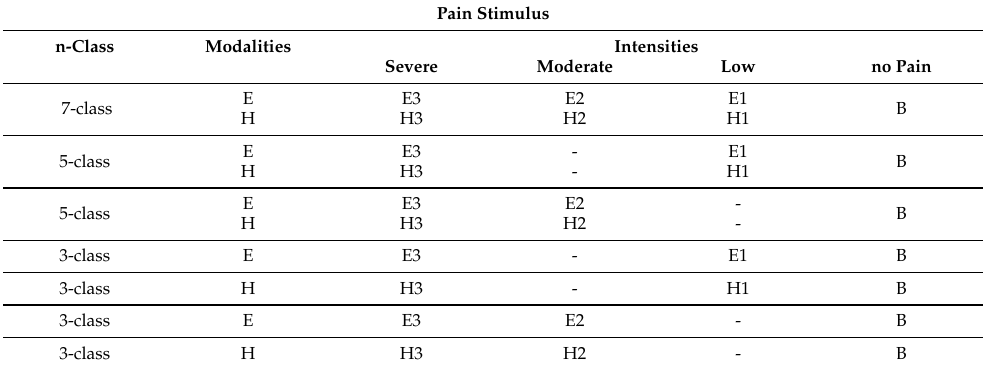
Table 1. List of the seven classification tasks used in the experiments (rows). Different combinations of no pain (Baseline = B) versus of 3 pain stimulus intensities and 2 pain stimulus modalities (Electrical = E and Heat = H)